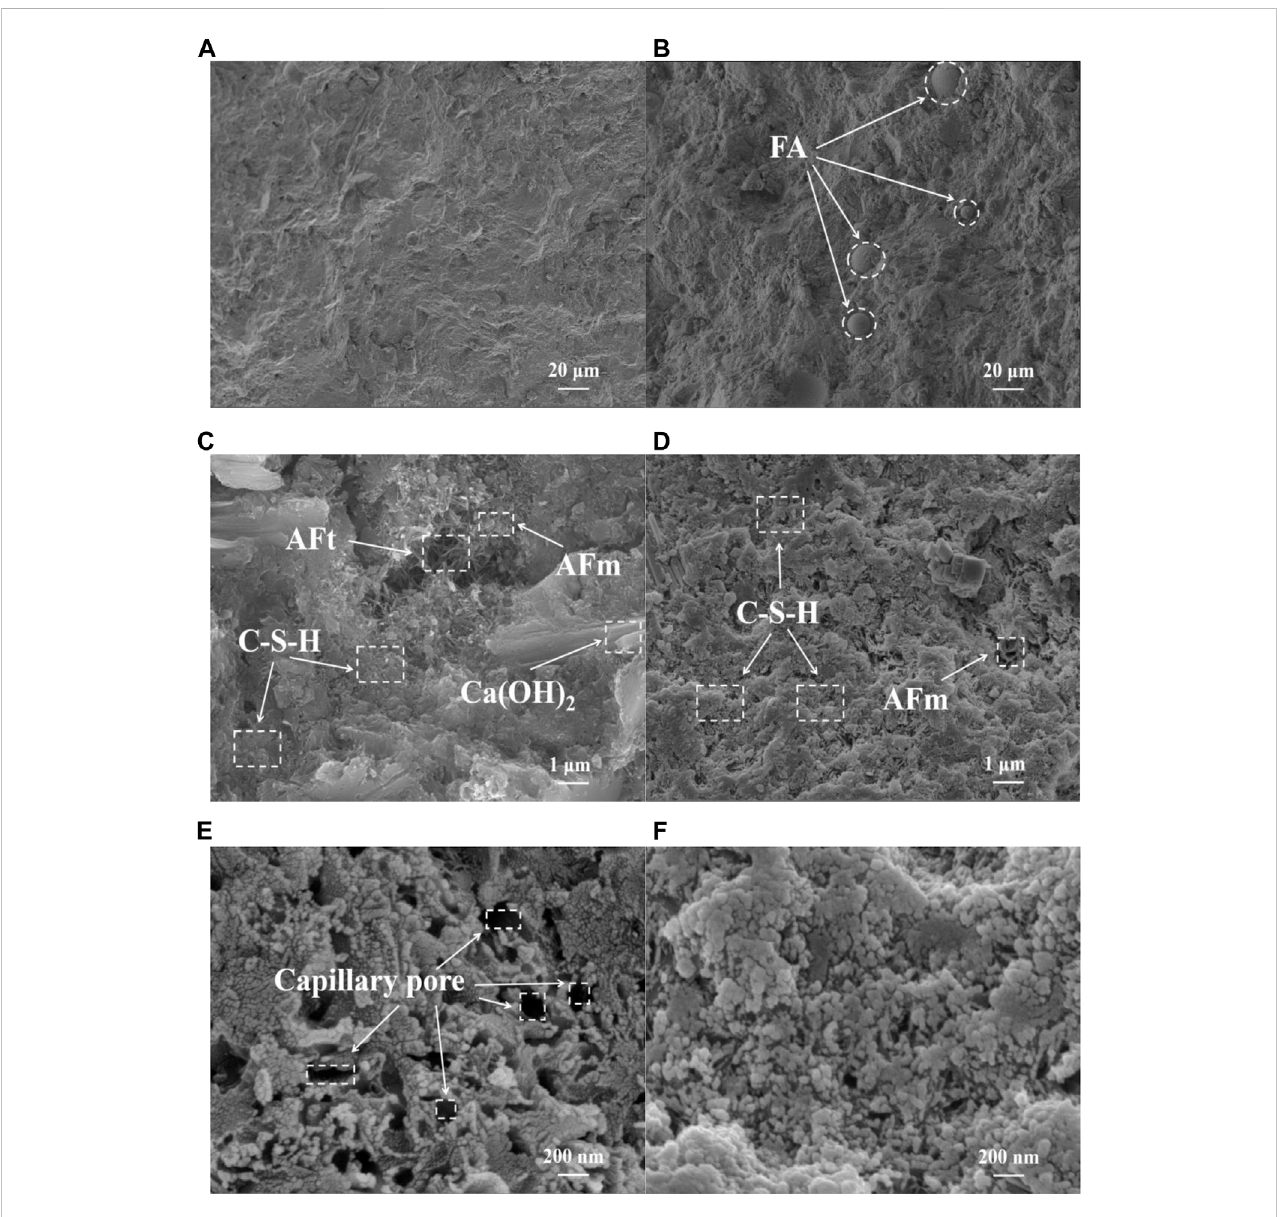
FIGURE 6 Comparison of the micromorphology of (A), (C), and (E) PC and (B), (D), and (F) LHCC cured for 90 days.